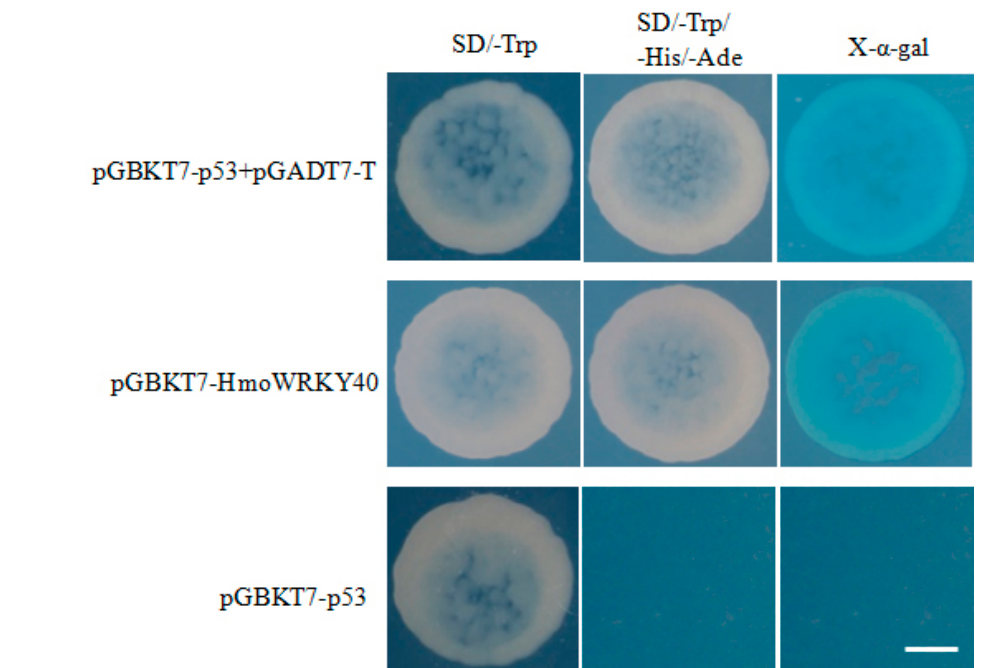
Figure 5. Transcriptional activation analyses of HmoWRKY40 in yeast cells. The coding region of HmoWRKY40 was inserted into the pGBKT7. The yeast cells of strain Y2HGold, harboring the pGBKT7-HmoWRKY40 plasmids, were Int. J. Mol. Sci. 2021 , 22 , x FOR PEER REVIEW cultivated on the SD/-Trp plate or the SD/-Trp-His-Ade plate for 3–5 d at 30 ◦ C, followed by the α -galactosidase assay. The pGBKT7 and pGBKT7-53+pGADT7-T were used as the negative and positive control, respectively. Bars = 2 mm.